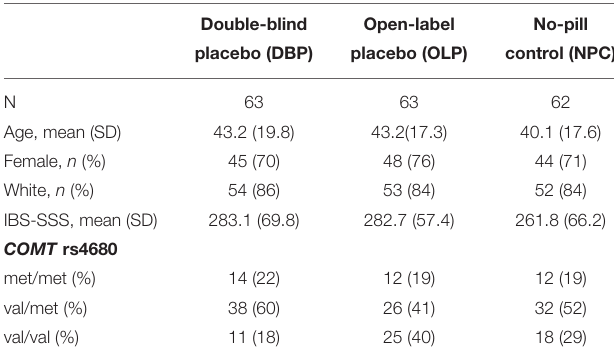
TABLE 1 | Demographics, baseline characteristics, and COMT rs4680 distribution by treatment